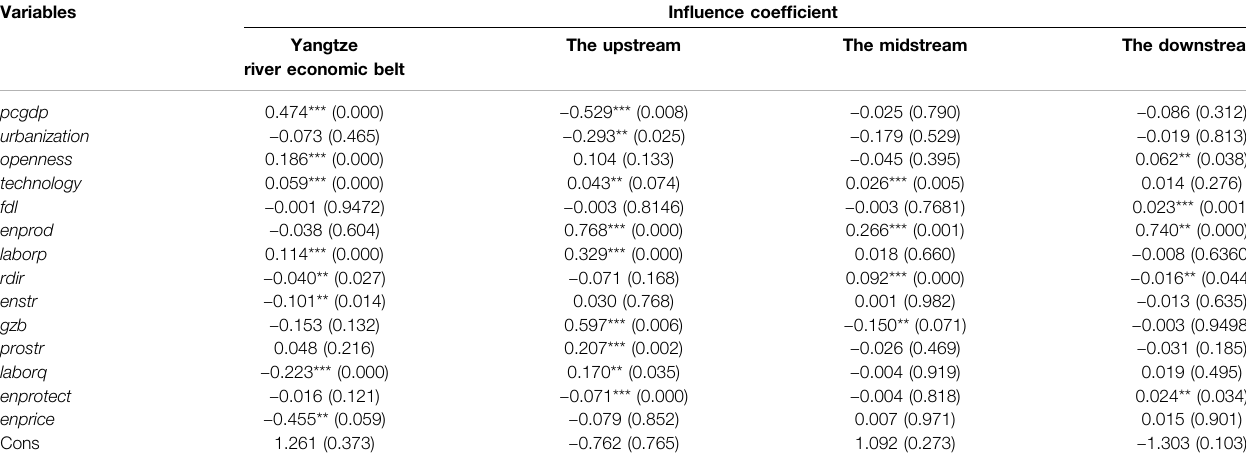
TABLE 2 | Regression results of in fl uencing factors of Yangtze River Economic Belt and its sub-regions. Variables In fl uence coef fi cient Yangtze river economic